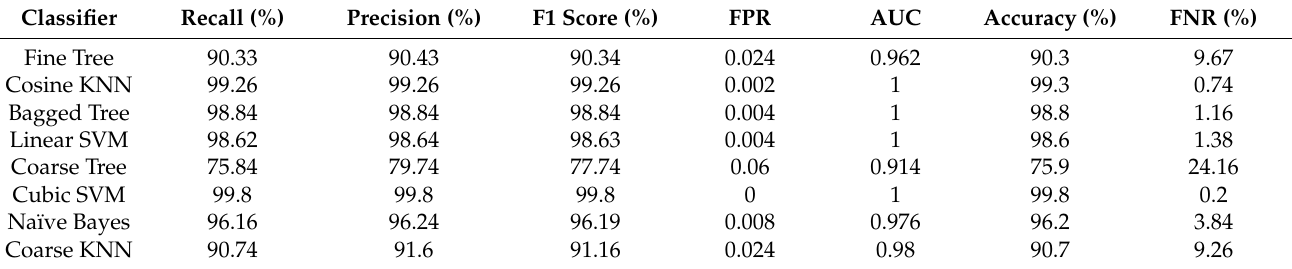
Table 7. Classification results of fused features.